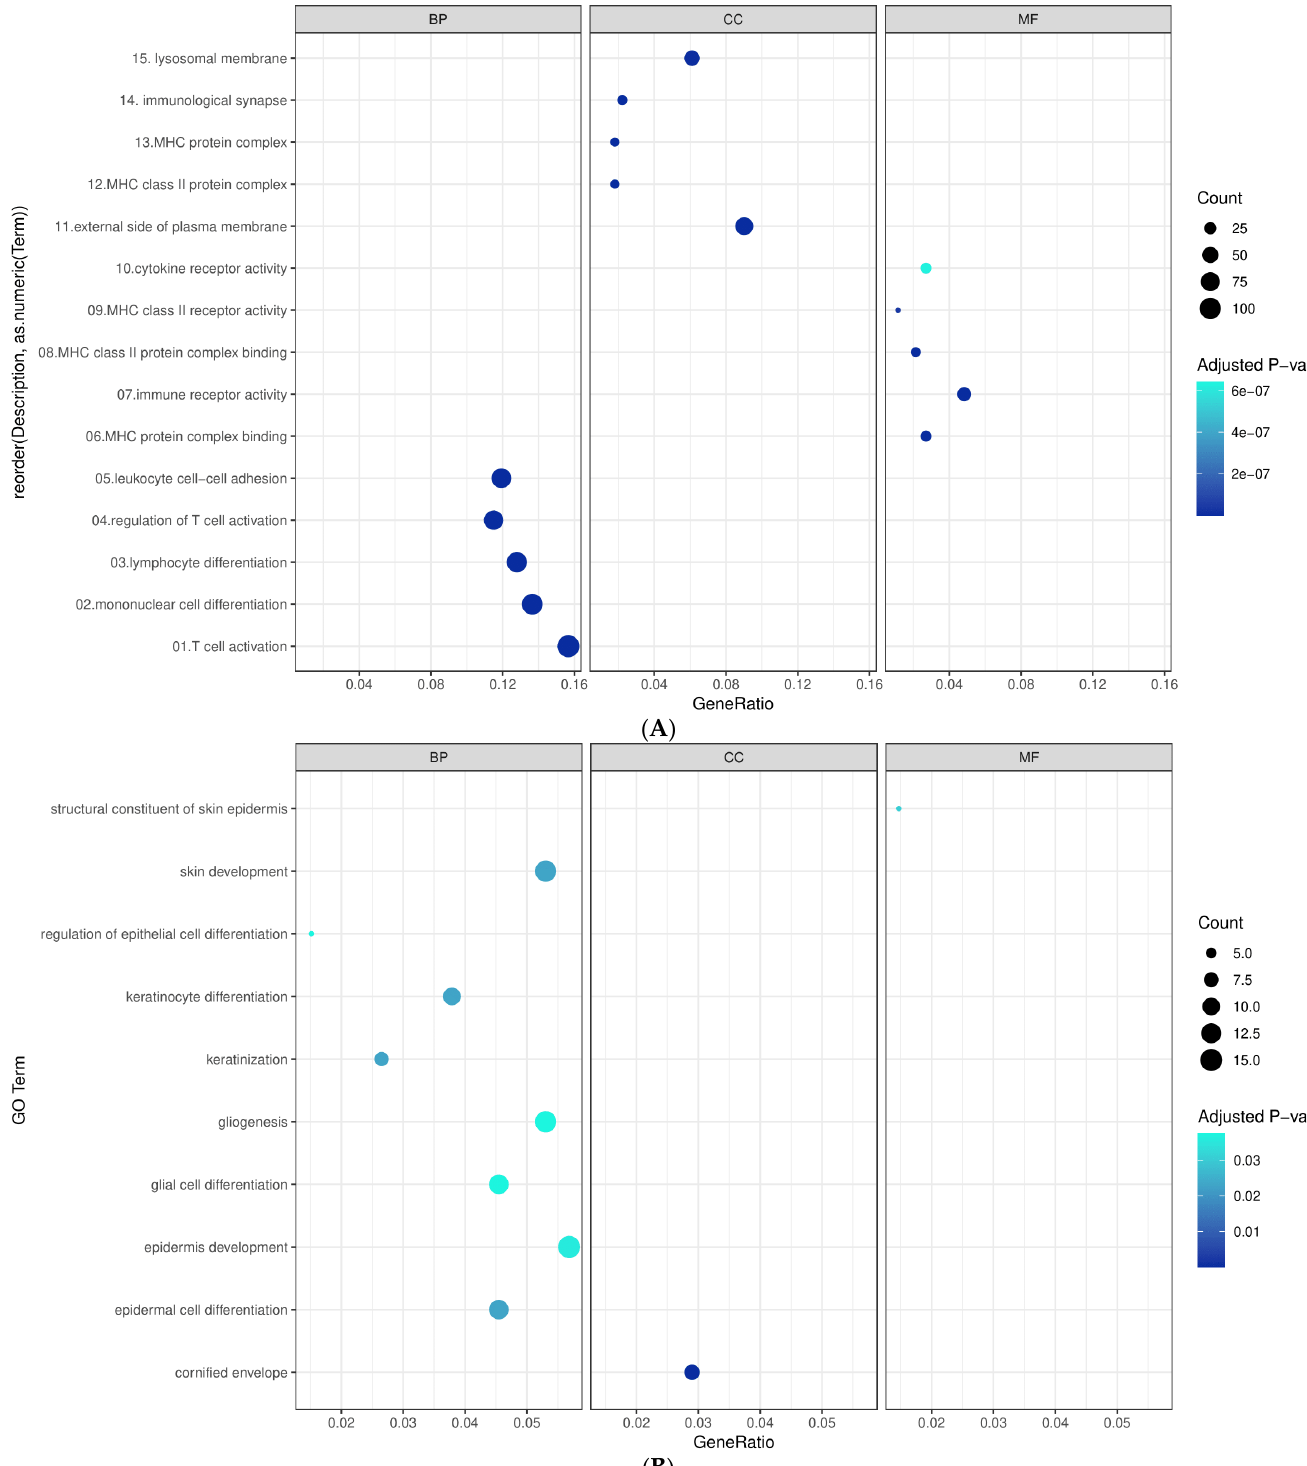
Figure 5. Functional enrichment analysis of the 1066 DEGs: ( A ) GO for the upregulated DEGs. ( B ) GO for the downregulated DEGs.